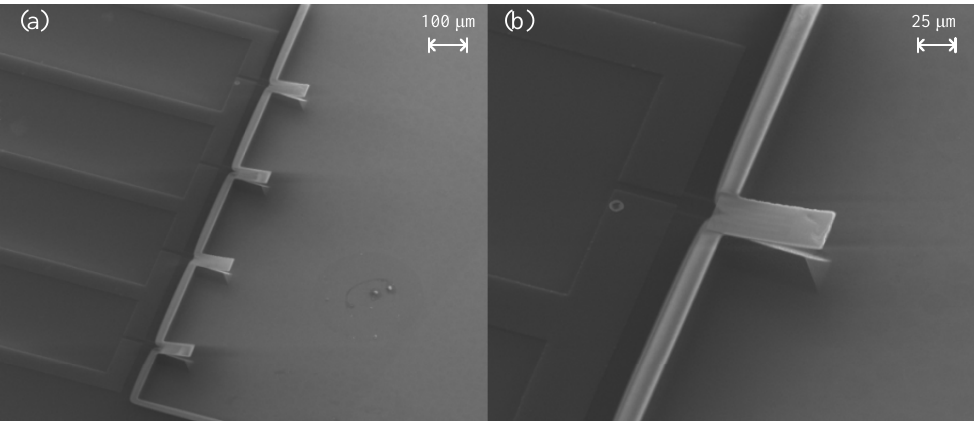
Figure 4. SEM image of ( a ) four microcantilevers that make up the Wheatstone bridge and ( b ) a sensing microcantilever respectively.